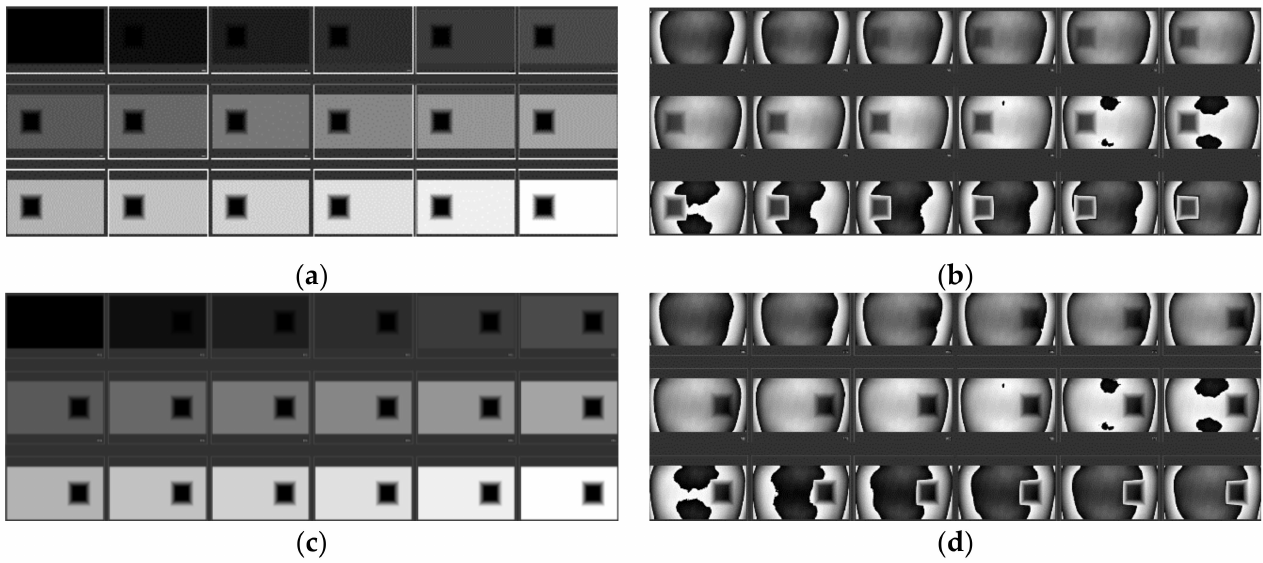
Figure 4. Left sequence of 18 phase response calibration holograms before ( a ) and after ( b ) inherent WFD compensation and right sequence of before ( c ) and after ( d ) inherent WFD